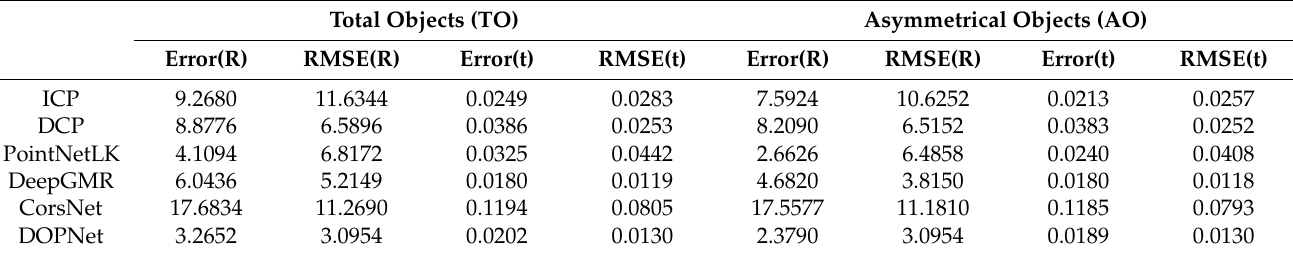
Table 1. Test on unseen